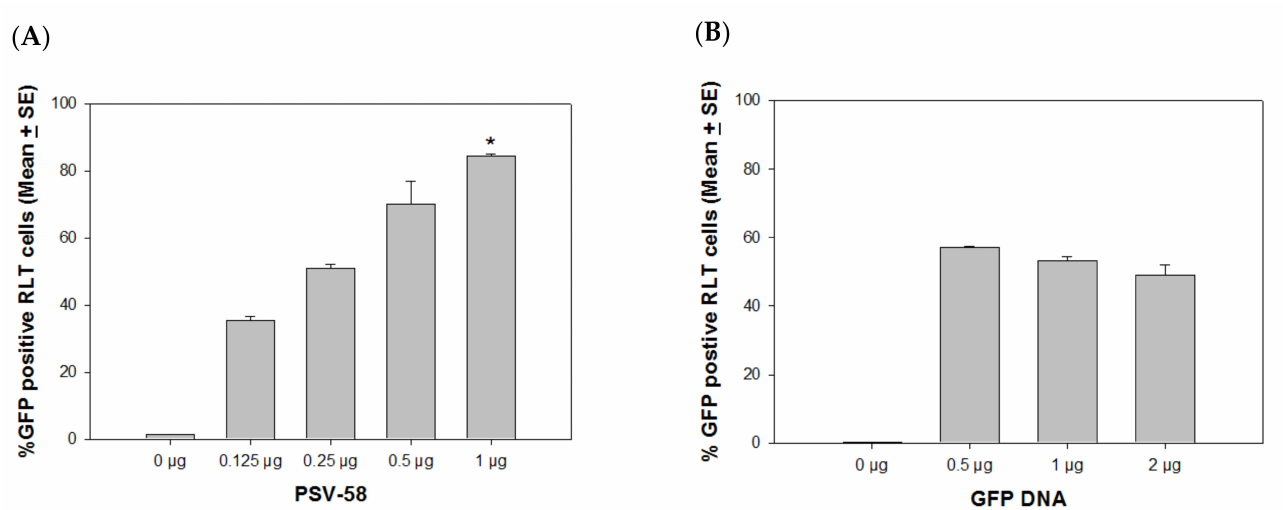
Figure 3. Dose curve to determine the optimal capsid/DNA ratio. ( A ) Different amounts of PSV58 (0.125, 0.25, 0.5, and 1 µ g) were mixed with 0.5 µ g of GFP DNA and added to SV40 LT immortalized rabbit cells (RLT). The 1 µ g PSV-58 group showed increased numbers of positive cells when compared with the 0.125 and 0.25 µ g groups ( p < 0.05, unpaired Mann Whitney test, indicated by *) ( B ) A range of GFP DNA was delivered by 1 µ g of PSV58 to test for optimum delivery. An increased amount of GFP DNA did not show increased delivery efficiency; 1 µ g PSV58 delivering 0.5 µ g GFP DNA was the most efficient ratio for external DNA